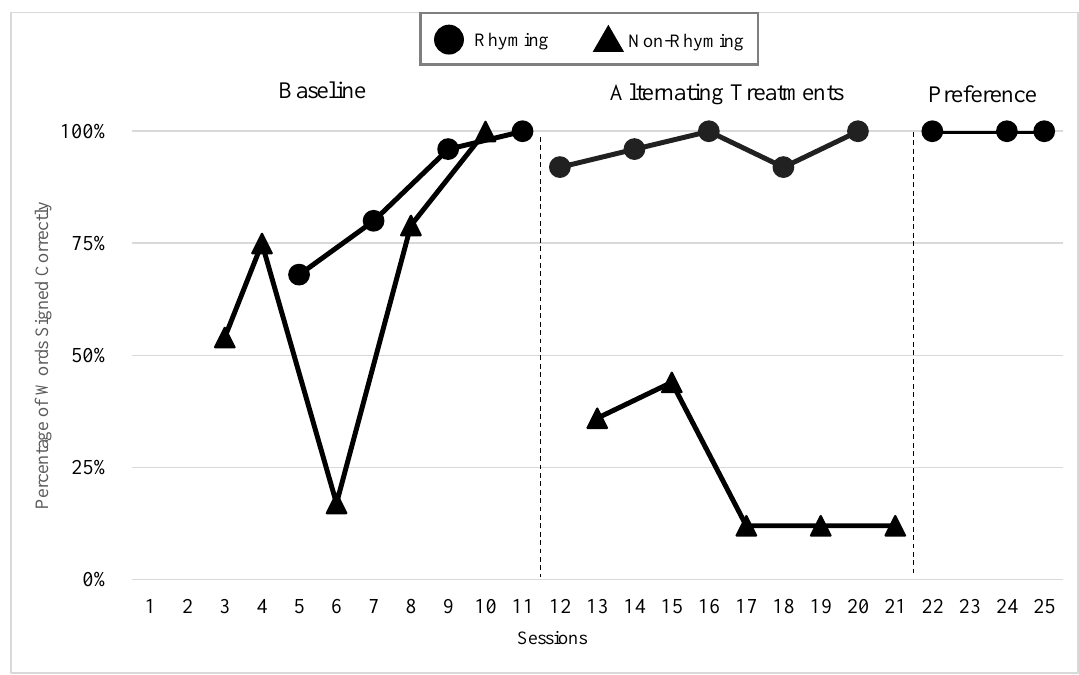
Figure 11. Giada’s Percentage of Words Signed Correctly in Recitation.